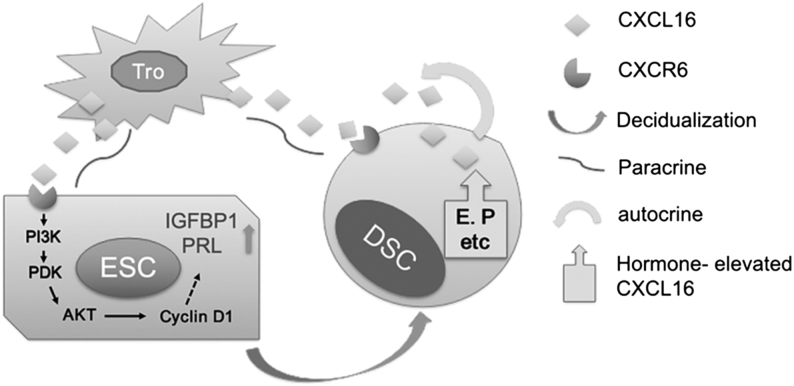
CXCL16/CXCR6 interaction promotes endometrial decidualization via PI3K-PDK1-AKT-Cyclin D1 pathway. The trophoblast-derived CXCL16 interacts with CXCR6 in ESCs, and thus, induces the decidualization of ESCs by activating the PI3K/PDK/AKT/Cyclin D1 signalling pathway. Furthermore, the decidualised ESCs (DSCs) autocrine CXCL16 and steroid hormones (such as oestrogen and progesterone) have positive feedback on DSCs and further improve decidualization during pregnancy.